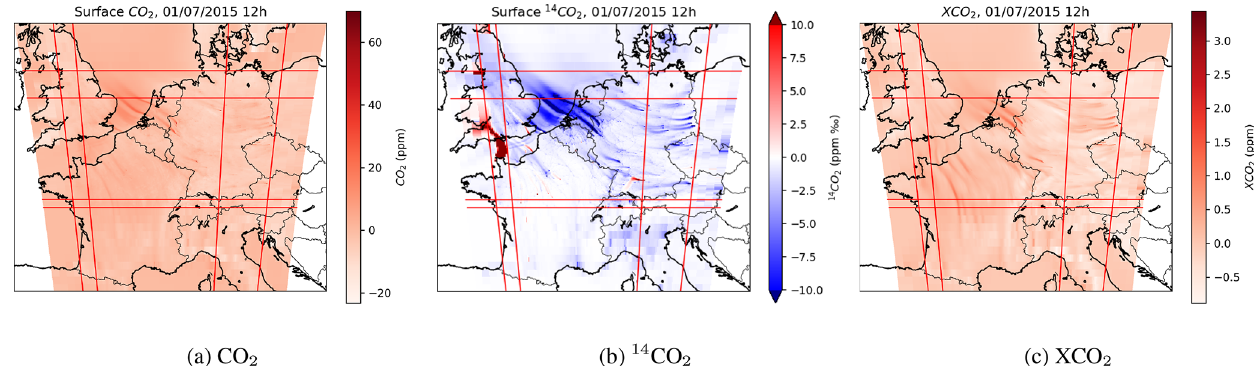
Figure 3. CO 2 (ppm) and 14 CO 2 (ppm‰) mole fractions at the surface and XCO 2 (ppm) at 12:00UTC, on 1 July 2015: simulations from 00:00 to 12:00UTC , without initial and boundary conditions.